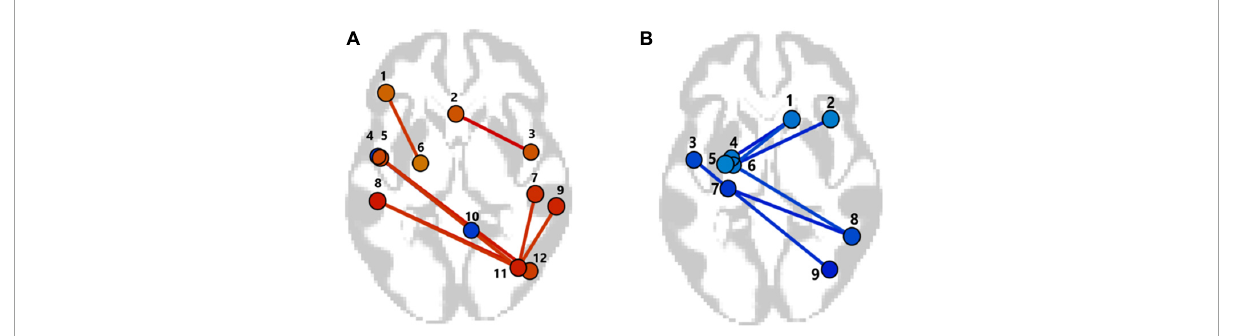
FIGURE5 The patterns of functional links, corresponding to the fMRI resting-state functional connectivity (rsFC) differences in the non-demented APOE4+ carriers and non-carriers ( p -FDR < 0.05). (A) Between groups contrast APOE4+ > APOE –. Only the networks with significant positive rsFC values in APOE4+ carriers or in non-carriers ( p -FDR < 0.05) are presented. 1—Lateral PreFrontal Cortex left, LPFC l; 2—Subcallosal Cortex SubCalC; 3—Inferior Temporal Gyrus right, anterior division, aITG r; 4—Inferior Temporal Gyrus left, anterior division, aITG l; 5—Planum Polare left, PP l; 6—Anterior Parahippocampal Gyrus left, aPaHC l; 7—Parietal Operculum right, PO r; 8—Parietal Operculum left, PO l; 9—Salience Supramagrinal right, Salience SMG r; 10—Cerebellum9 right, Cereb9 r; 11—Visual Laterale right, VisLat r; 12—Lateral Occipital Cortex right iLOC r. (B) Between groups contrast APOE4– < APOE4+. Only the networks with significant negative rsFC values in APOE4– or APOE+ carriers ( p -FDR < 0.05) are presented. 1—Superior Frontal Gyrus right, SFG r; 2—Middle Frontal Gyrus right, MFG, r; 3—Planum Polare left, PP l;